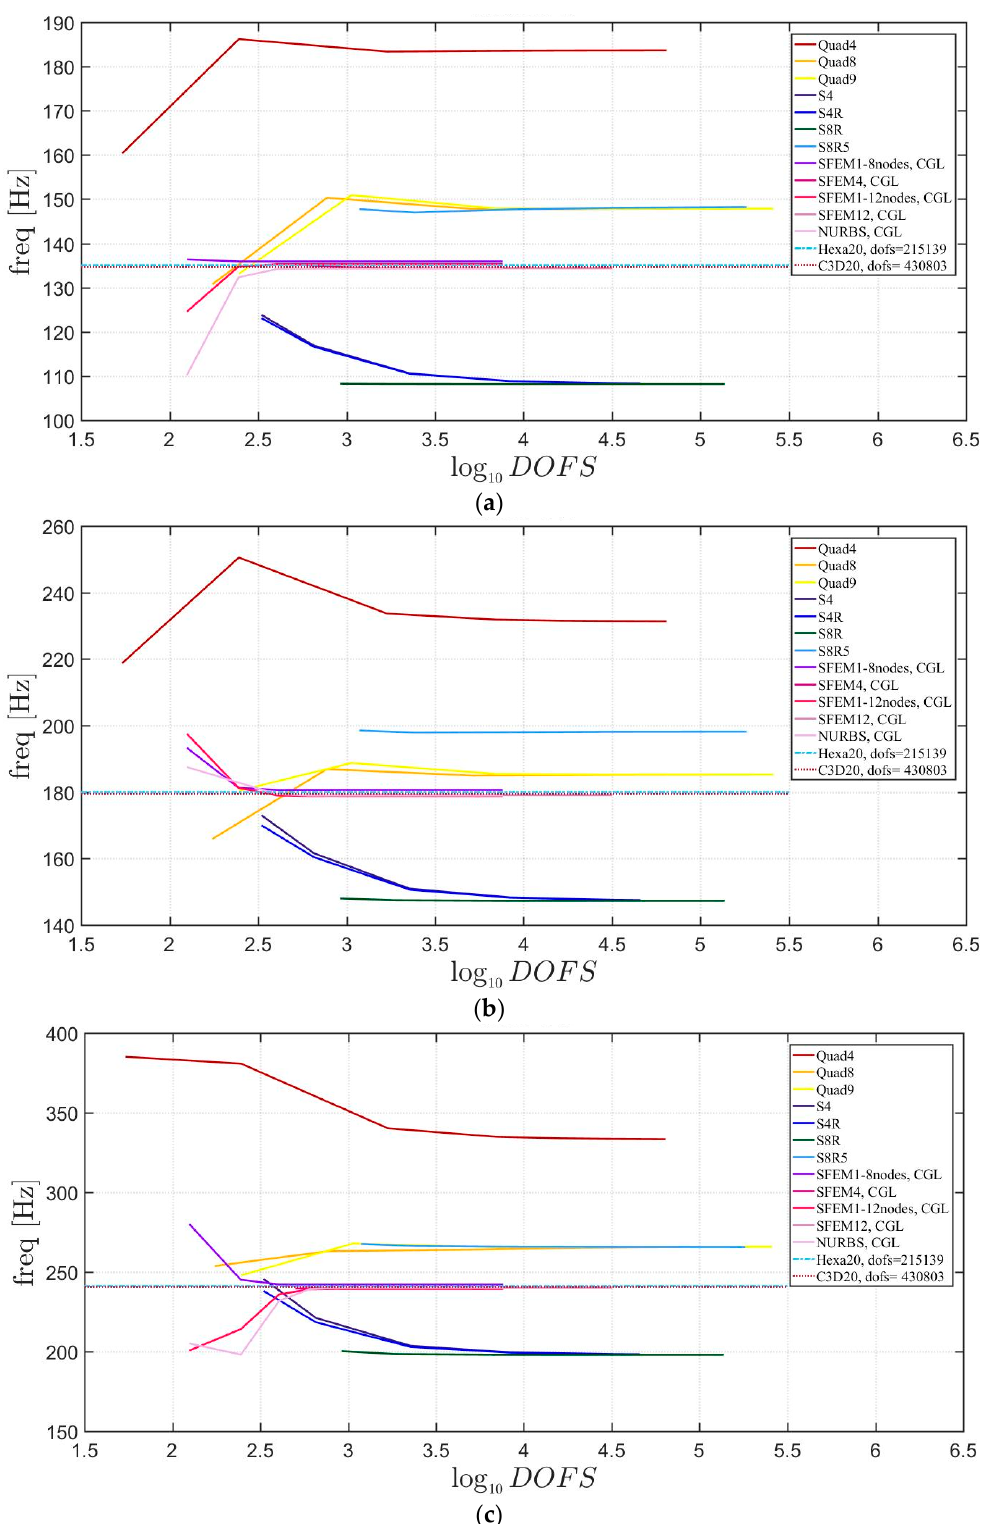
Figure 29. First three natural frequencies of an elliptic plate with a / b = 1.5 a not-symmetric lamination scheme and a / h = 10: ( a ) First frequency; ( b ) Second frequency; ( c ) Third frequency.